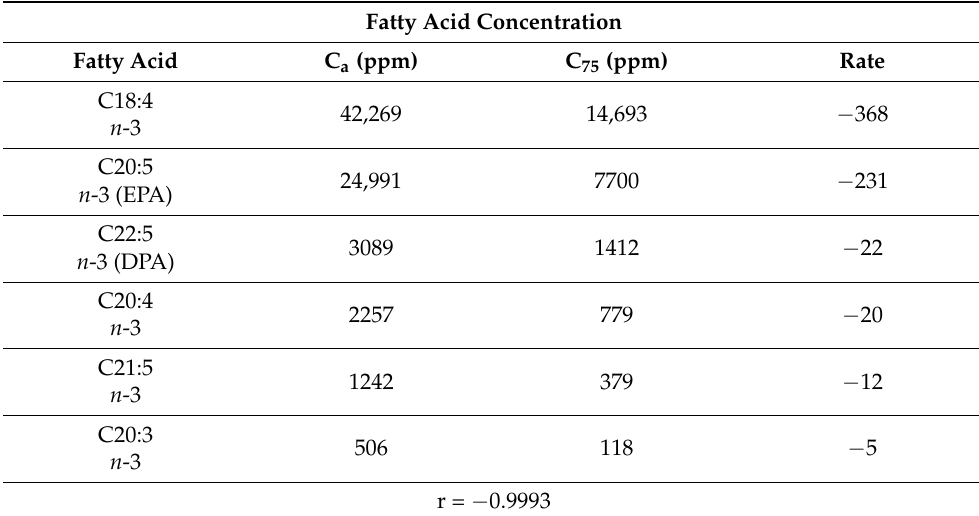
Figure 3. ( a ) Effect of the GI tract on the oxidation of individual omega-3 FAs of fish oil supplement: Brand D; ( b ) close view (zoom) of some omega-3 FA from a; ( c ) effect of the GI tract on the oxidation of total omega-3 FAs. Table 4. Initial oxidation rates of PUFAs during the digestion of supplement Brand D samples.